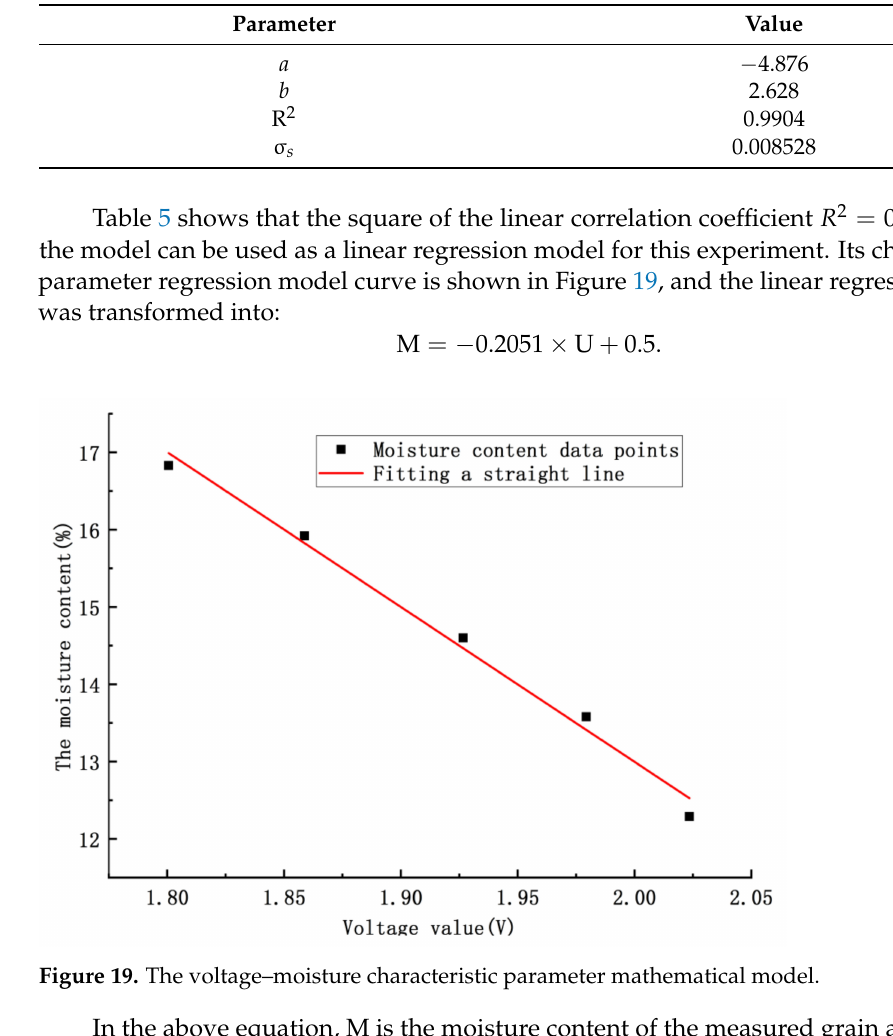
Table 5. Parameter values.